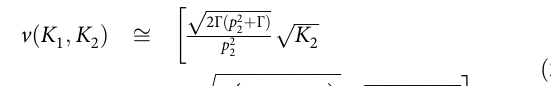
ffiffiffiffiffiffiffiffiffiffiffiffiffiffiffiffiffiffiffiffi